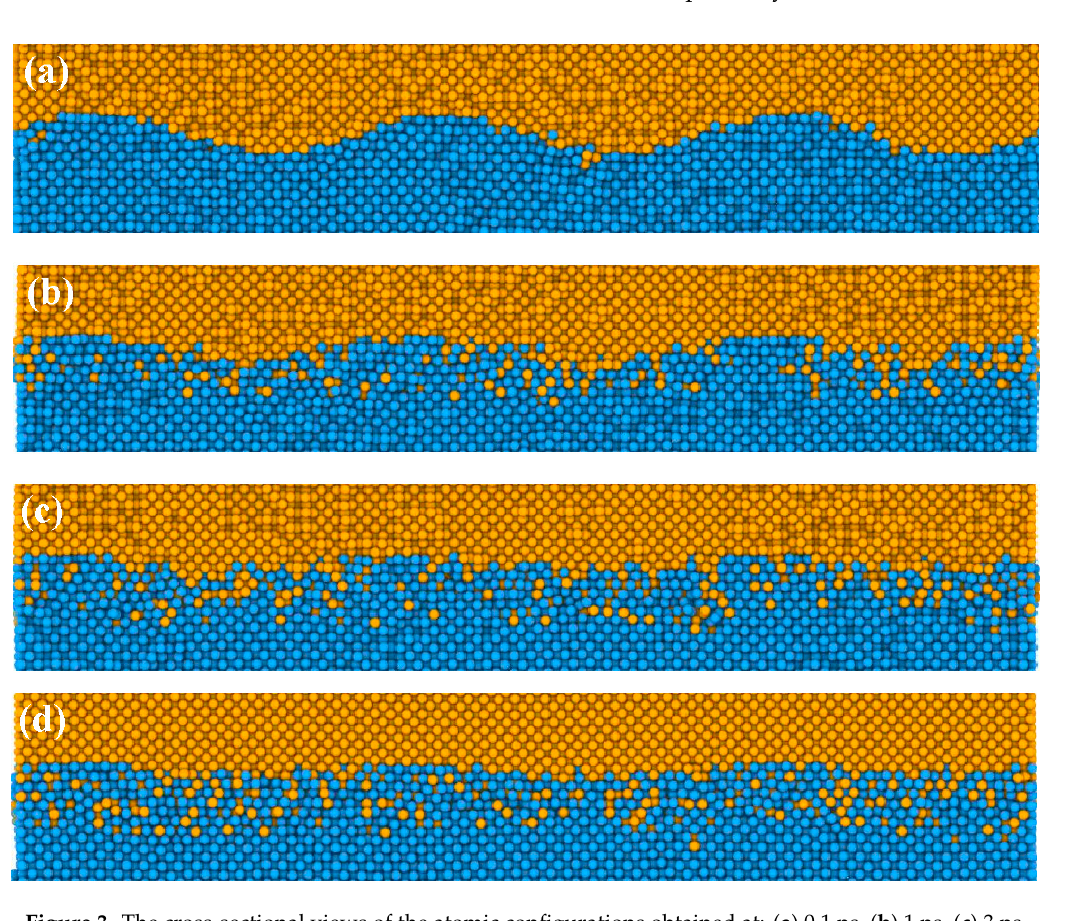
4 of 11 Figure 2. Configurations of the interfacial deformation process during the compression stage at: ( a ) 20 ps, ( b ) 40 ps, ( c ) 60 ps, and ( d ) 120 ps.